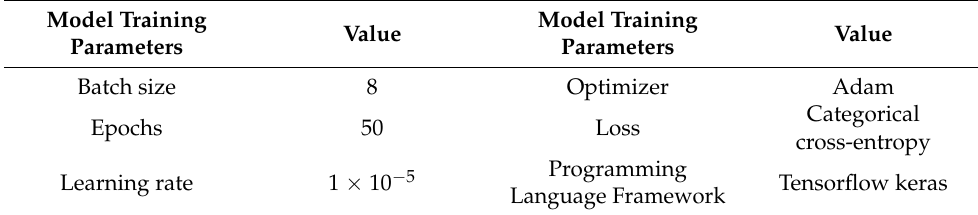
Table 4. Model Training Parameters.